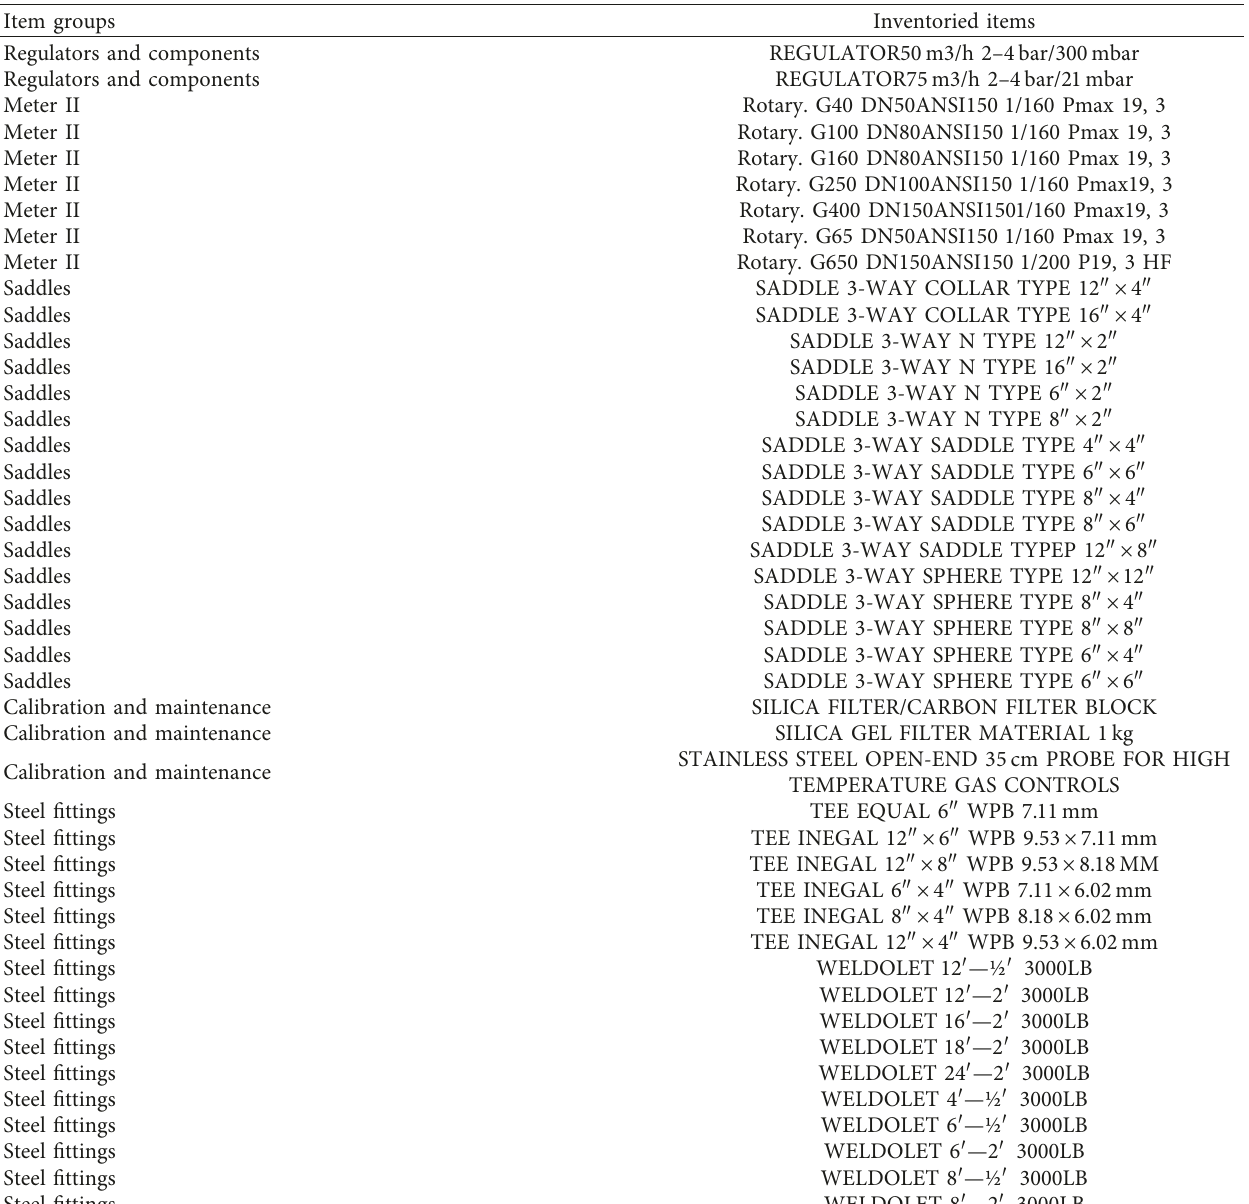
Table 8: Linguistic terms and corresponding SFNs. Linguistic terms